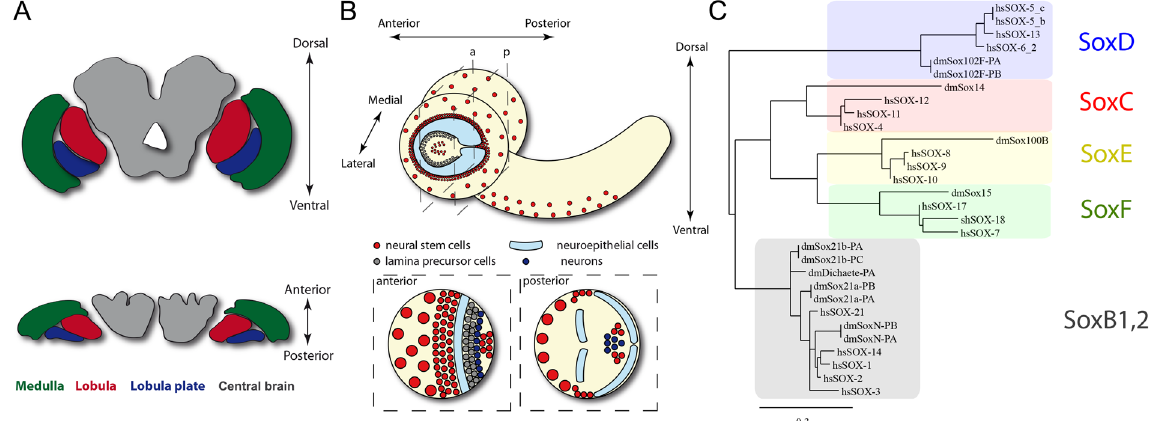
Figure 1. The Drosophila brain and the Sox family of transcription factors. ( A ) Schematic representation of the Drosophila melanogaster adult brain. The optic lobe medulla (green), lobula (red) and lobula plate (blue) neuropils are represented. The neuronal cell bodies are located in the periphery of the brain and not in the neuropils. ( B ) Diagram of the larval brain showing and anterior and posterior sections of a brain lobe. Neuroepithelial cells are shown in cyan, neural stem cells (neuroblasts) in red, lamina precursor cells (LPCs) in gray and neurons in blue. ( C ) Phylogenetic analysis of the human and Drosophila Sox family of transcription factors. The two isoforms of Sox102F/SoxD cluster with human SoxD members: SOX-5, SOX-6 and